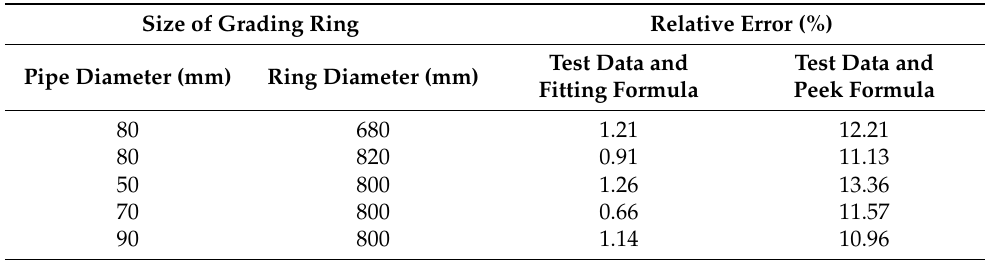
Table 5. The relative errors between the test data and the COI calculated by the fitting formula and Peek